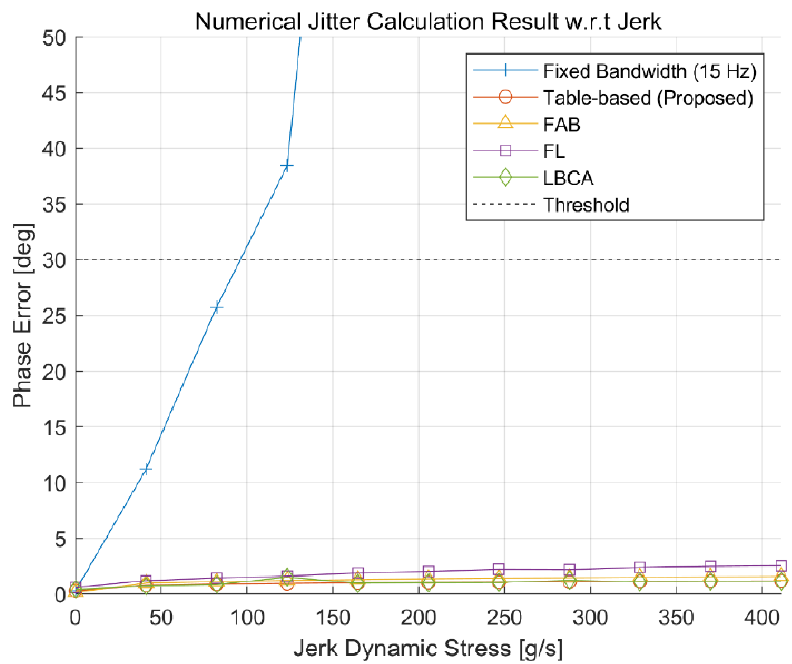
Figure 17. Numerical jitter calculation result with respect to the jerk dynamic stress. All adaptive DPLL algorithms have similar performances. Table 3. Theoretical computational complexities of each adaptive DPLL algorithm.